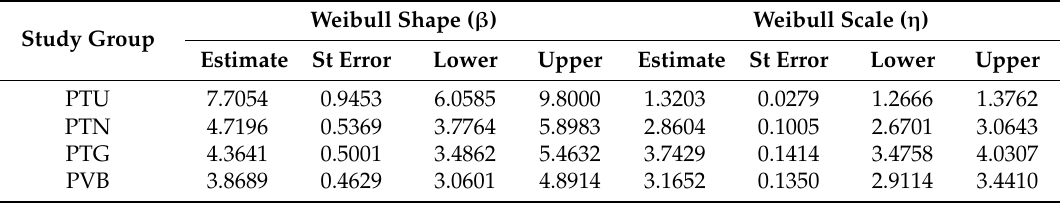
Table 2. Weibull statistics of time to failure of the study groups.